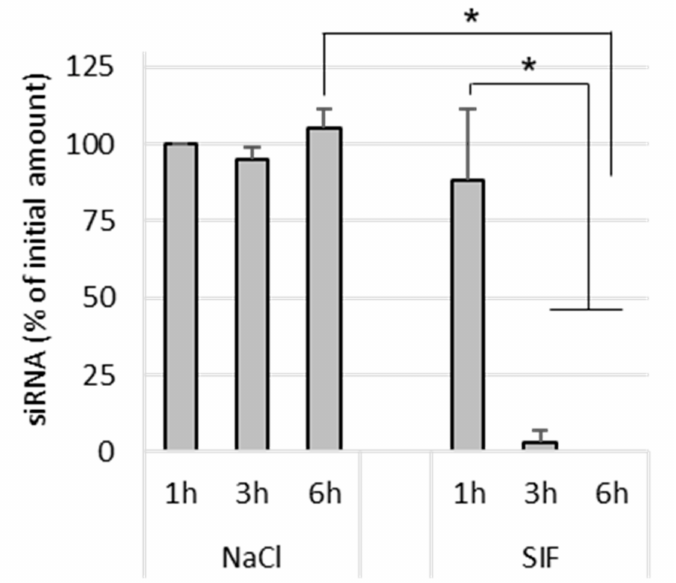
Figure 5. Effect of NaCl (150 mM) and simulated intestinal conditions on siRNA stability. Naked siRNA was incubated for 1 h, 3 h and 6 h at 37 ◦ C in NaCl or SIF, before being assayed by gel electrophoresis. The results are expressed as % initial amount of siRNA used (mean values ± SD, n = 3; * p <